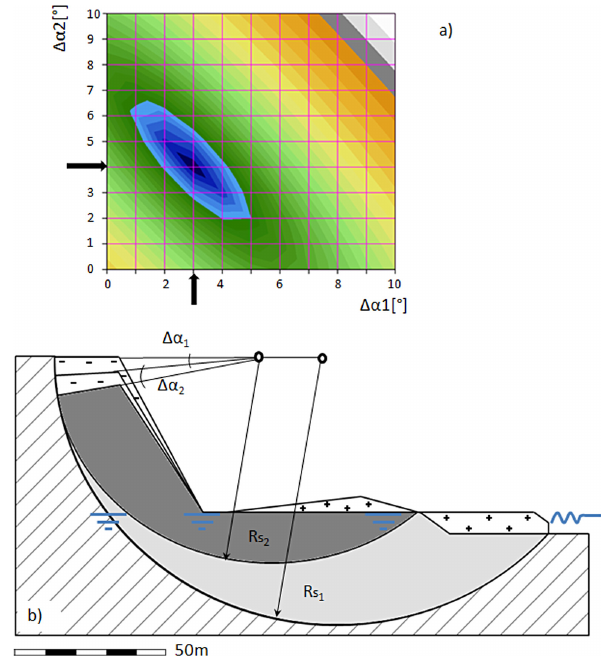
Fig. 7. Double slider block model. (a) Grid search for optimum parameters: the L2-norm for different rotation angles ( α 1 , α 2 ) of the primary and secondary slider blocks plotted, the minimum is marked by arrows; (b) the optimized double slider block model, blue lines mark the water